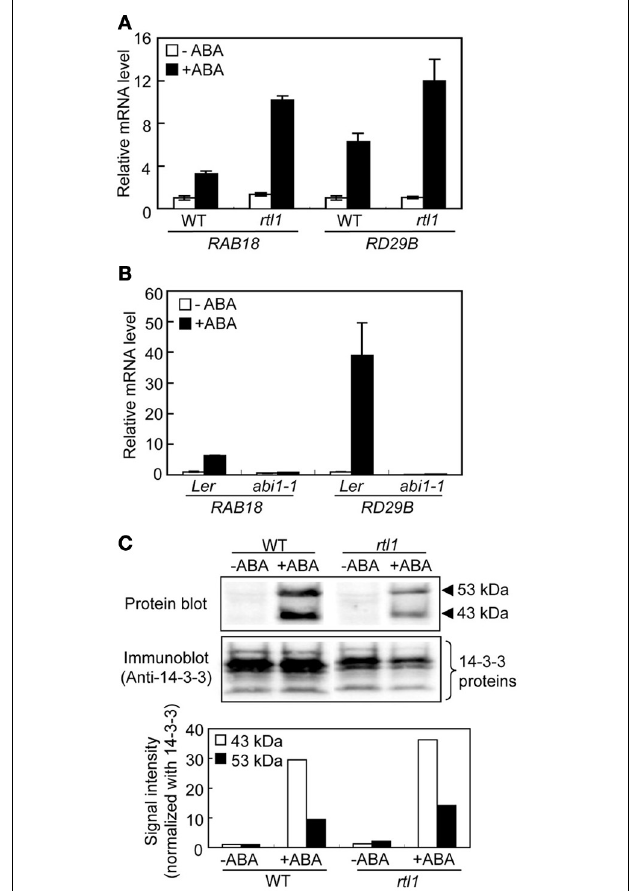
FIGURE 1 | ABA-responsive gene expression and ABA-induced phosphorylation of bHLH transcription factors (the AKSs) in guard cells from the rtl1 mutant. (A) The expression levels of ABA-responsive genes, RAB18 and RD29B , in GCPs from WT and rtl1 mutant plants, measured using real-time quantitative PCR. Transcript levels were normalized to that of TUB2 . GCPs were incubated in the presence or absence of 20 µ M ABA for 1h. Data represent the means of three measurements ± standard deviations (SDs). (B) Expression of ABA-responsive genes in GCPs from abi1-1 and L er plants. The experimental conditions were as described in (A) above. (C) ABA-induced protein phosphorylation in GCPs from WT and rtl1 plants. Phosphorylation of 43- and 53-kDa proteins was detected via protein blot analysis using GST-fused 14-3-3 protein as a probe (“Protein blot”), and endogenous 14-3-3 proteins were detected by immunoblotting using an anti-14-3-3 protein antibody (“Anti-14-3-3 protein”). GCPs were incubated in the presence or absence of 20 µ M ABA for 10min. The lower panel shows the relative phosphorylation levels of the AKSs, and the 43- and 53-kDa proteins, quantified by calculating the ratios of the signal intensities of the protein blot bands to those of immunoblot bands of 14-3-3 proteins. The data are expressed relative to the level of phosphorylation in ABA-untreated WT plants. The experiment was repeated twice on different occasions and yielded similar